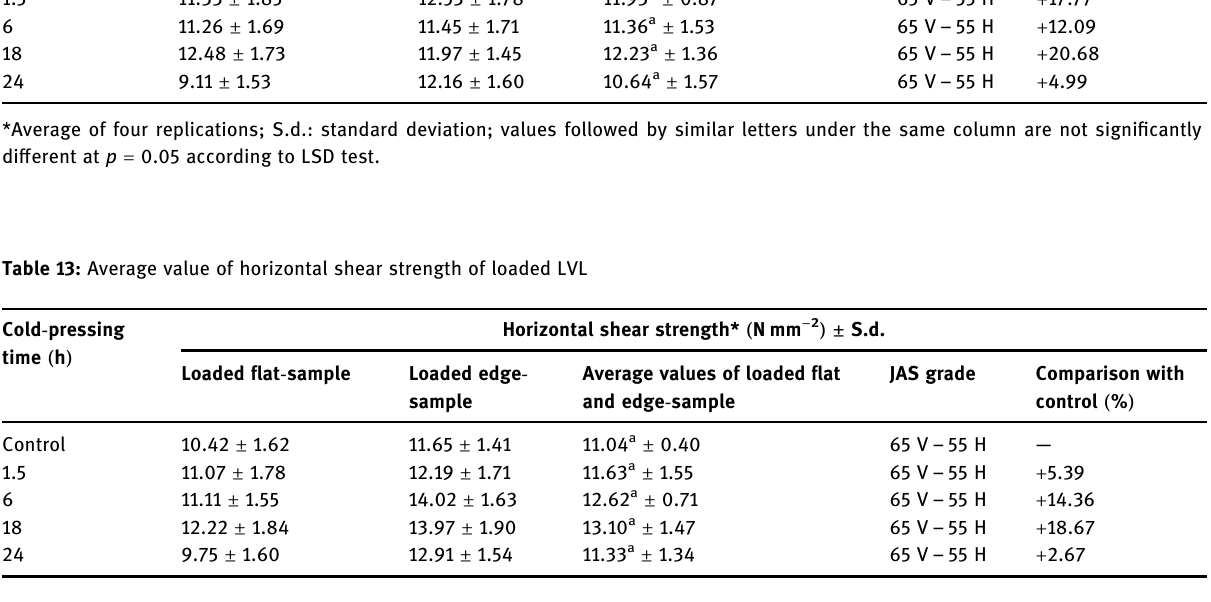
Cold - pressing time ( h )